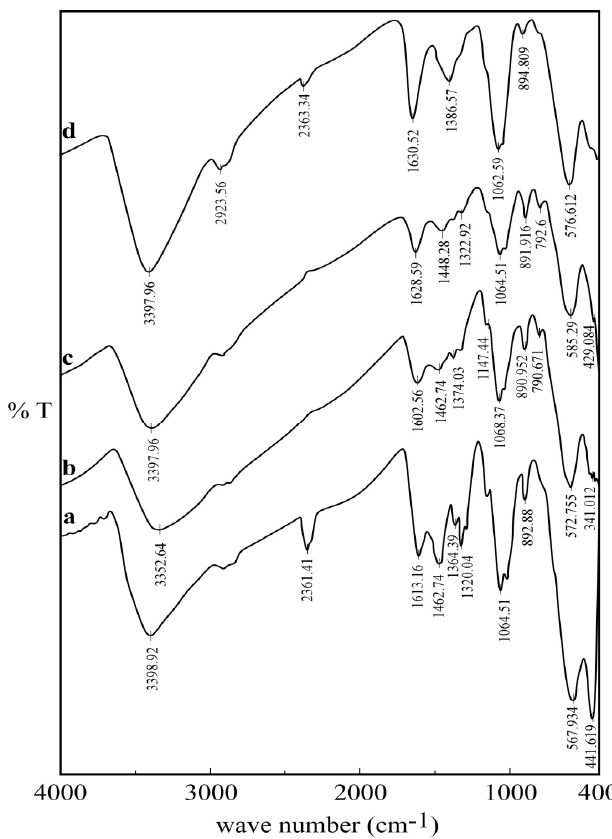
Figure 2. FTIR spectra of ( a ) chitosan-magnetite nanoparticles; ( b ) after cross-linking; ( c ) cross-linked chitosan magnetite with the spacer arm; and ( d ) cysteine-adsorbent. The XRD pattern of cysteine-functionalized chitosan-magnetic nano-based particles is shown in Figure 3, together with the assignments of the different peaks representative of Fe 3 O 4 : (111), (220), (311), (400), (422), (511), (440) and (622). These peaks are consistent with the database in the